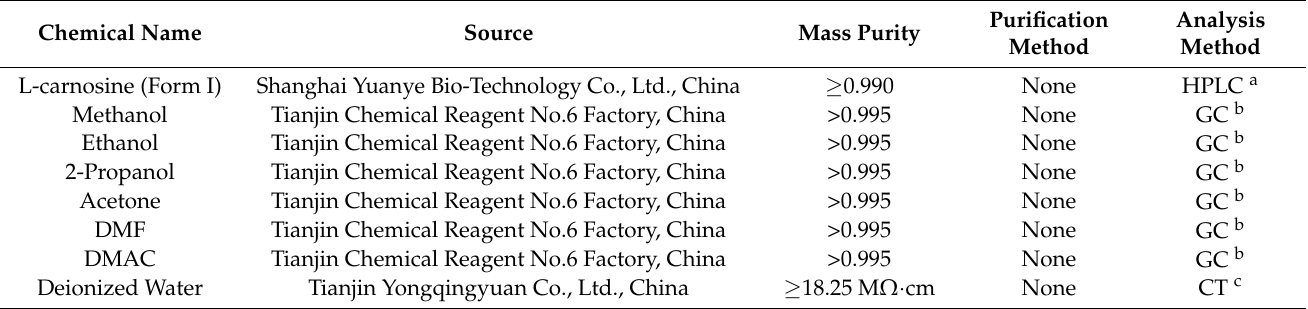
Table 1. Sources and mass fraction purity of MAC chemicals used in this